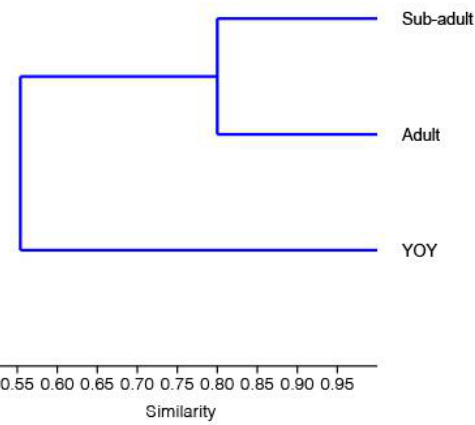
Figure 6. Cluster analyses in the population of Latium between age classes with greater similarities in the diets of sub-adults and adults.